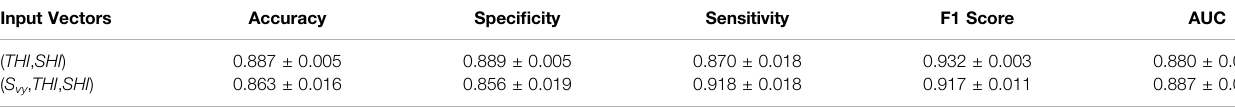
TABLE 4 | Results of feature selection using the grid search for the VCG-only model on the training dataset